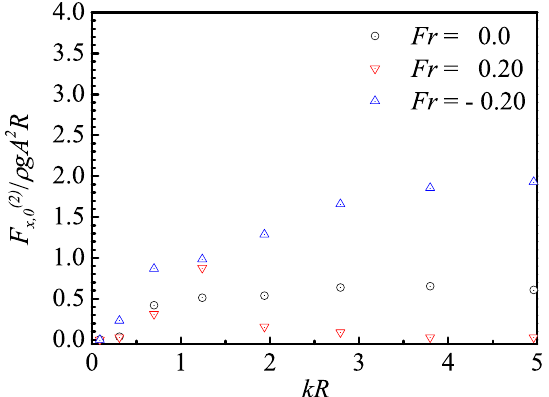
Figure 17. The 1st-order motion RAOs of the 6MW spar-type FOWT at different Froude numbers. Note that the problem of a body undergoing a positive forward speed in waves is equivalent to the problem of a body in waves and negative current by neglecting the interaction between the wave and current.